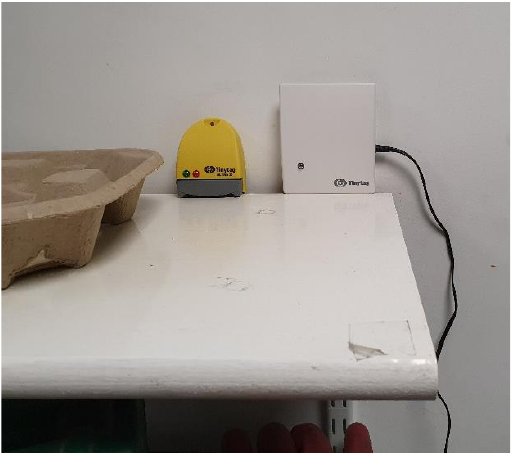
Figure 18. Monitors ’ positioning sample. Figure 18. Monitors’ positioning